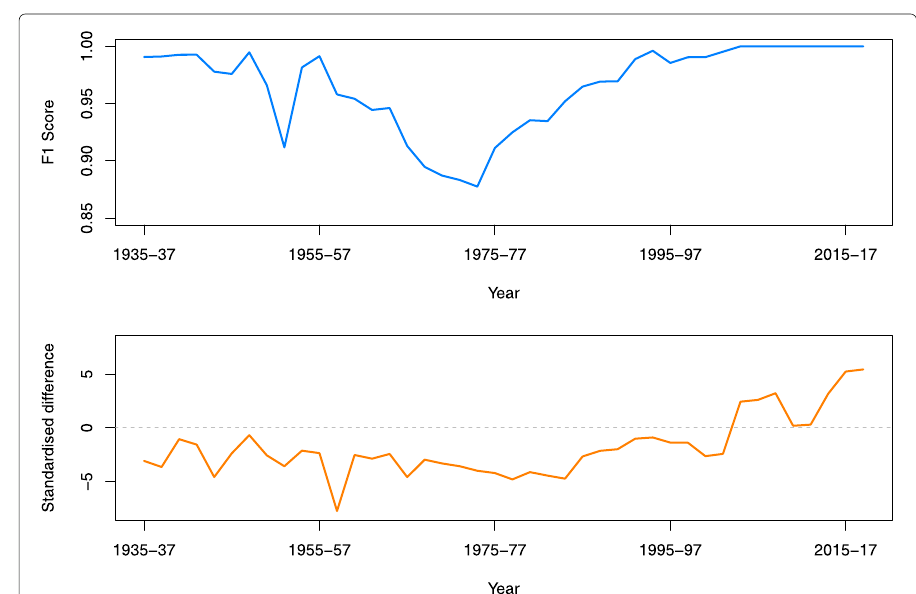
Fig. 2 Top: F1 Score for the House from 1935-37 (74 th House) to 2017-19 (115 th House). Bottom: Difference between the smallest standardised P ( Y i = Democrat ) among all true Democrats and the largest standardised P ( Y i = Democrat ) among all true Republicans for the House from 1935-37 (74 th House) to 2017-19 (115 th House). While there is some variability over time, F1 scores are relatively high for all Houses (minimum F1 score = 0.8776), indicating very strong performance of the GLaSS method in labelling members of the House as Democrat or Republican. In particular, every House from the 108 th (2003-05) onwards has an F1 score of 1, implying that the GLaSS method was able to perfectly identify the party affiliation of every member in those Houses. The plot of standardised differences shows the magnitude of overlap (values below the horizontal line at 0) or separation (values above the horizontal line at 0) between Democrats and Republicans, according to absorption probabilities calculated by the GLaSS method. F1 score appears to decrease with increasing magnitude of overlap, while also showing that the two parties have grown increasingly far apart since they first separated entirely in the 108 th